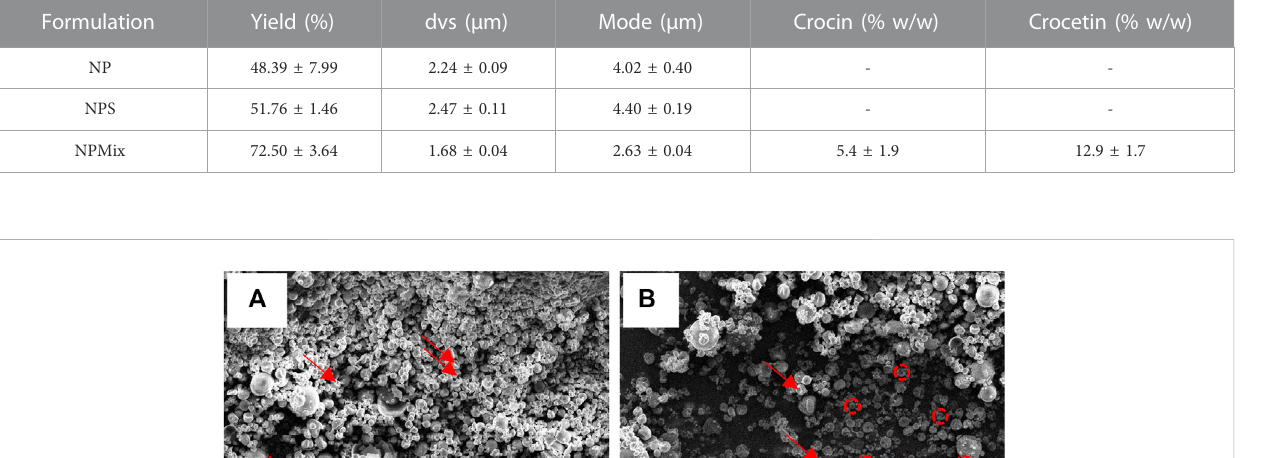
TABLE 3 Yield of the spray drying process and size of microparticles, expressed as mean volume-surface diameter (dvs) and mode. Data are reported as mean values ± standard deviation, n = 3 or 9. Formulation